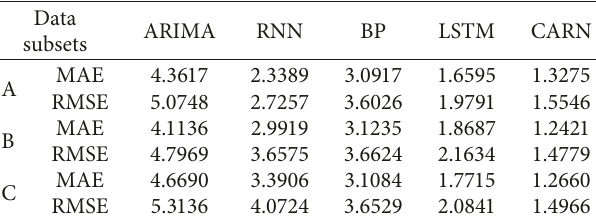
Figure 6: Errors of the prediction results of atmospheric quality data in different methods: subset data (a) from June to August in 2016, (b) from September to November in 2016, and (c) from December in 2016 to February in 2017. Table 3: Error evaluation indicators of the prediction results of atmospheric quality